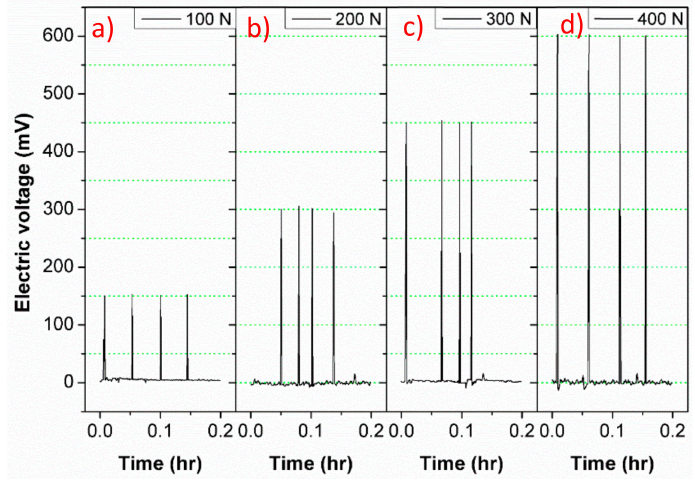
Figure 6. Electric voltage versus time of the PZTCC wafer under various impulse levels: ( a ) 100 N; ( b ) 200 N; ( c ) 300 N; ( d ) 400 N.